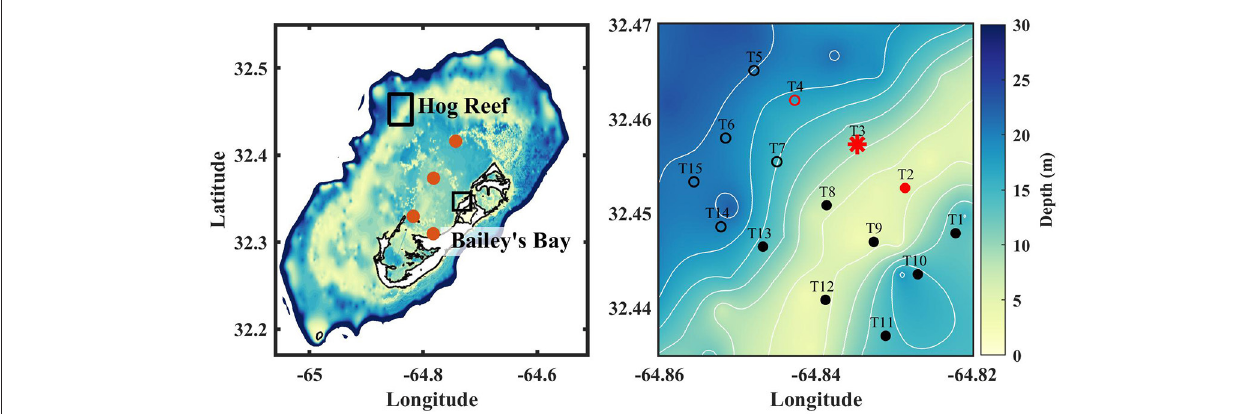
FIGURE 1 | (Left) Bathymetry of the Bermuda coral reef platform. Water depth > 200m is represented as white. Brown circles represent the four time series stations where monthly surface discrete samples for DIC and TA were taken between 2007 and 2012 (Andersson et al., 2014). Hog reef and Bailey’s Bay are outlined in black. (Right) Bathymetry of Hog reef; contours are every 3m. Stations for the spatial survey are shown as black circles. Open circles represent deep stations ( > 10m) that were not included in the regression analysis of TA-DIC data (see main text). Red circles indicate sensor deployment sites; BEAMS was deployed at T3 (red star).